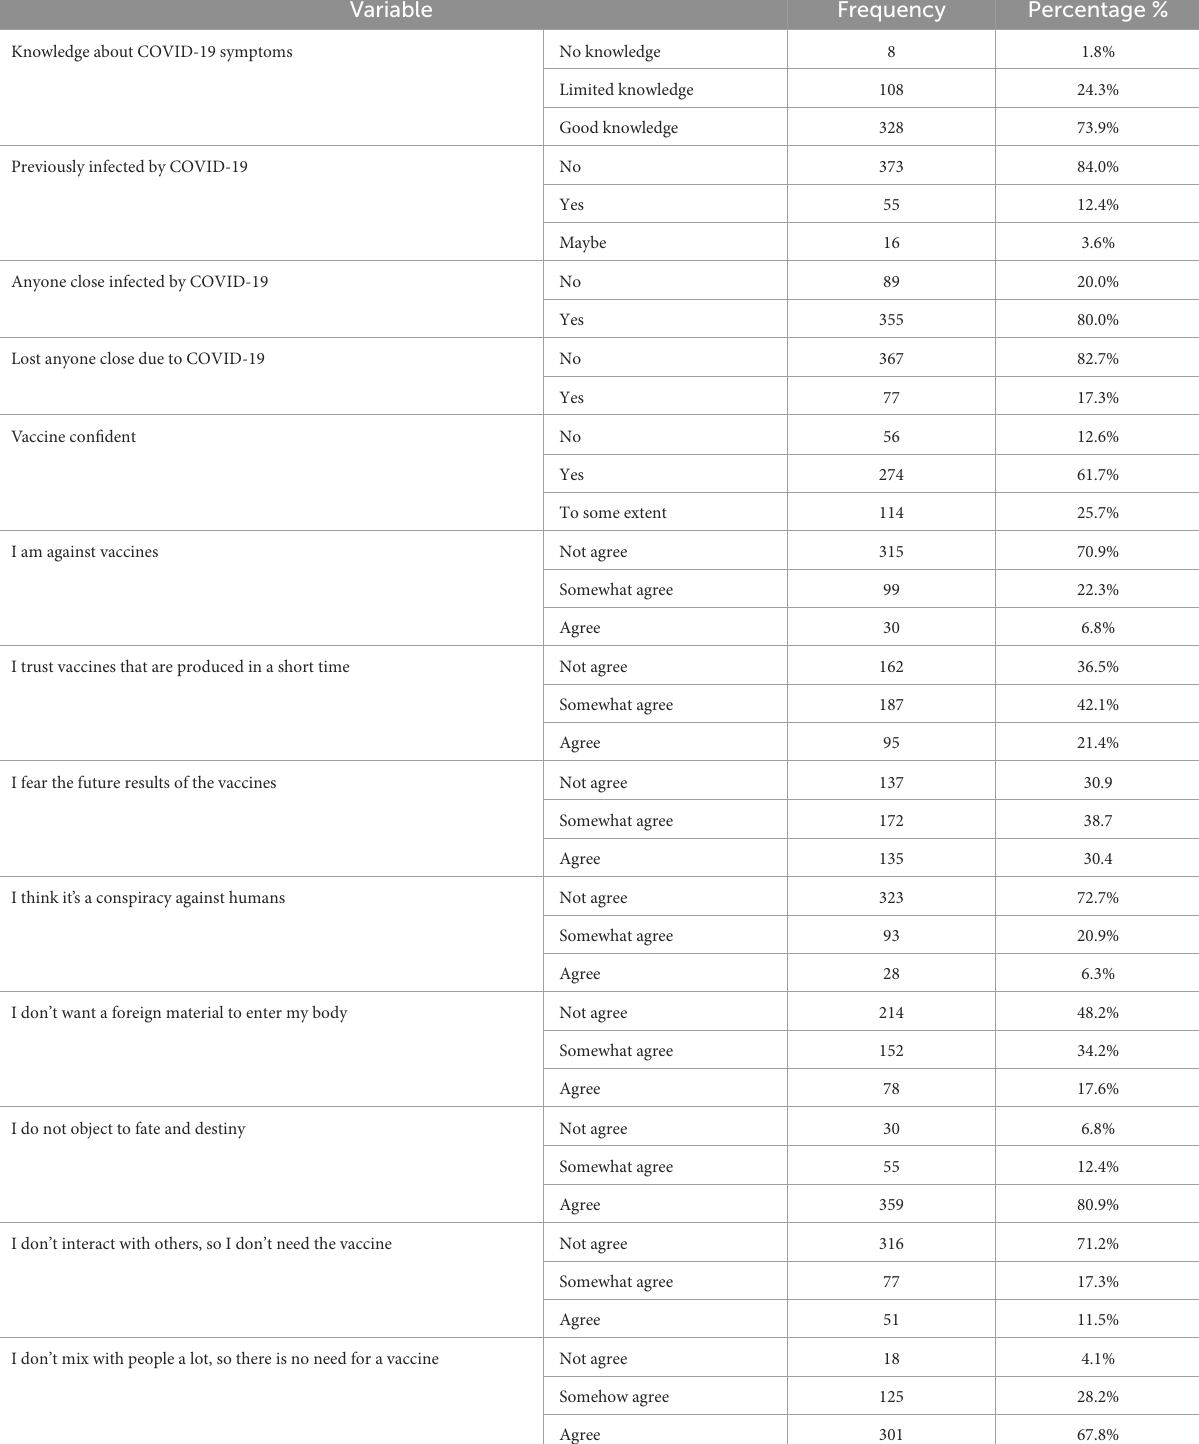
TABLE 2 Influence of personal characteristics on the decision to take the vaccine. Variable Frequency Percentage % Knowledge about COVID-19